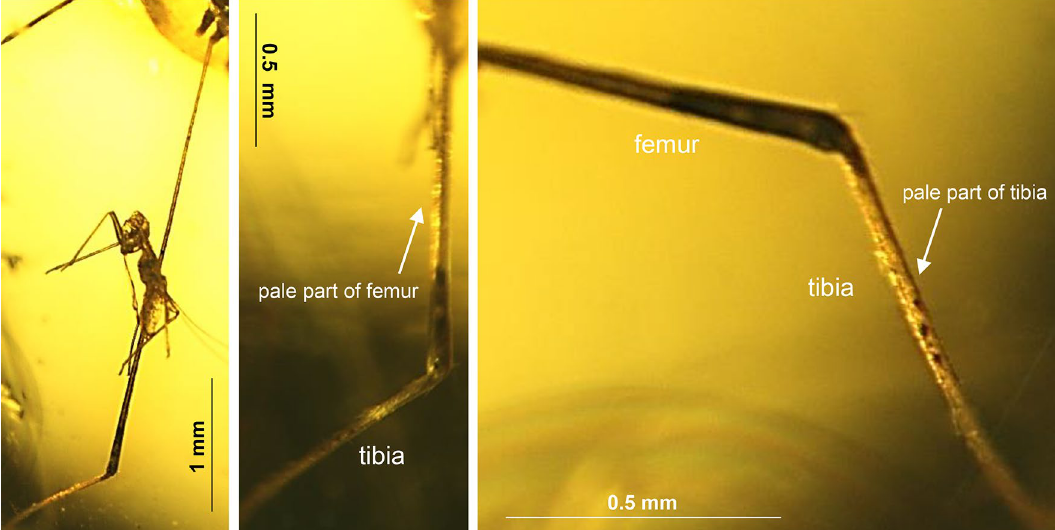
Figure 7. Elephantomyia ( Hoffeinsonia ) prima sp. nov. No. CCHH 874–1 (male), coll. Ch. & H. W. Hoffeins, holotype, photographs: ( A ) femur and part of tibia of hind leg; ( B ) pale parts of femur and tibia of hind leg visible; ( C ) enlarged view of pale part of hind